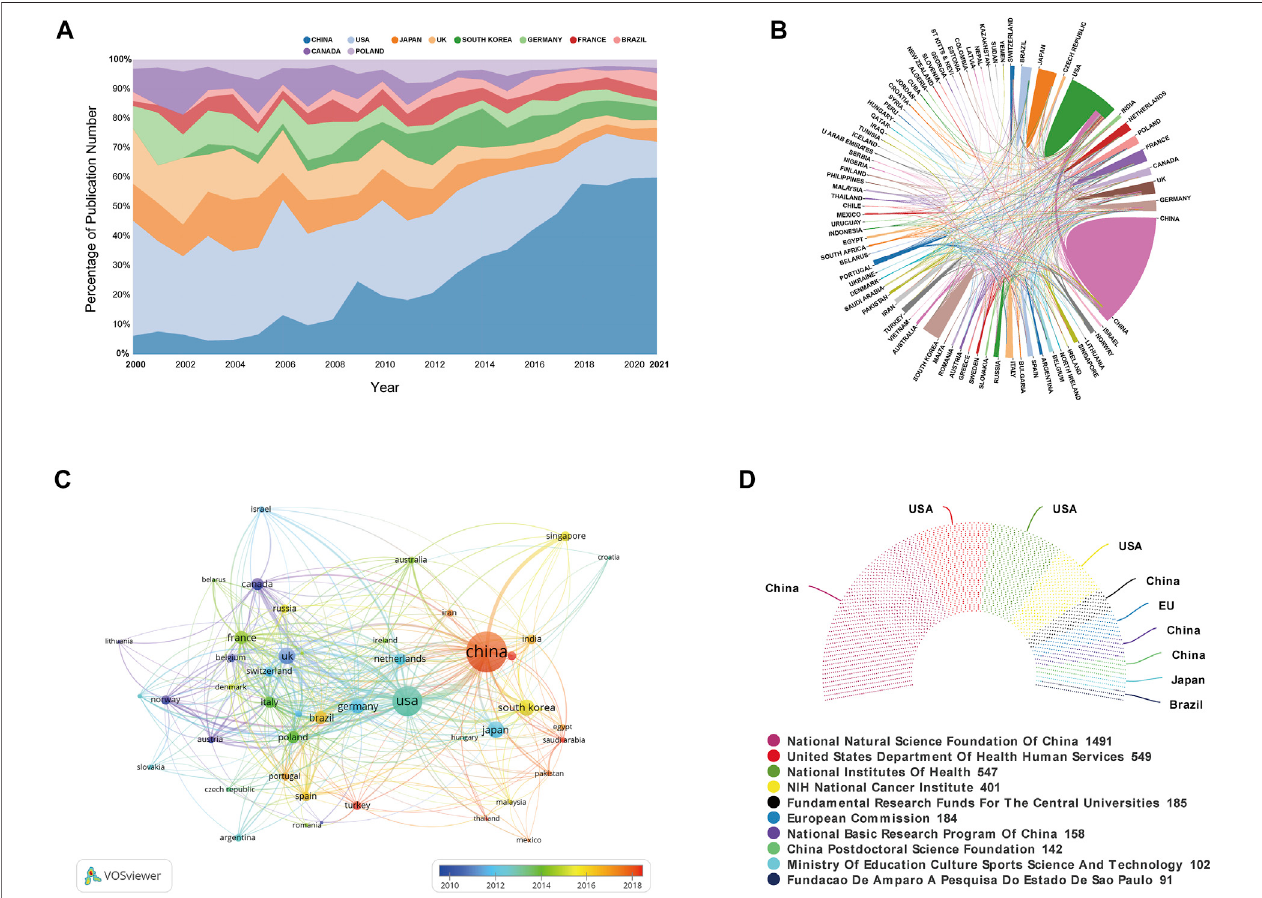
FIGURE 3 | (A) The top 10 country ’ s change trend in the relative proportion of annual publications from 2000 to 2021. (B) Cooperation between contributed countries.Linethicknesscorrelateswiththeintensityofthecloseness. (C) Countryco-authorshipanalysisbyVOSviewer.Inthisoverlayvisualizationmap,eachnodeisa country, and links between countries represent co-authorship relationship. The size of each node is proportional to the total number of publications. The node color re fl ects the corresponding average appearing year (AAY) according to the color gradient in the lower right corner. (D) The top 10 most active funding agencies involved in this